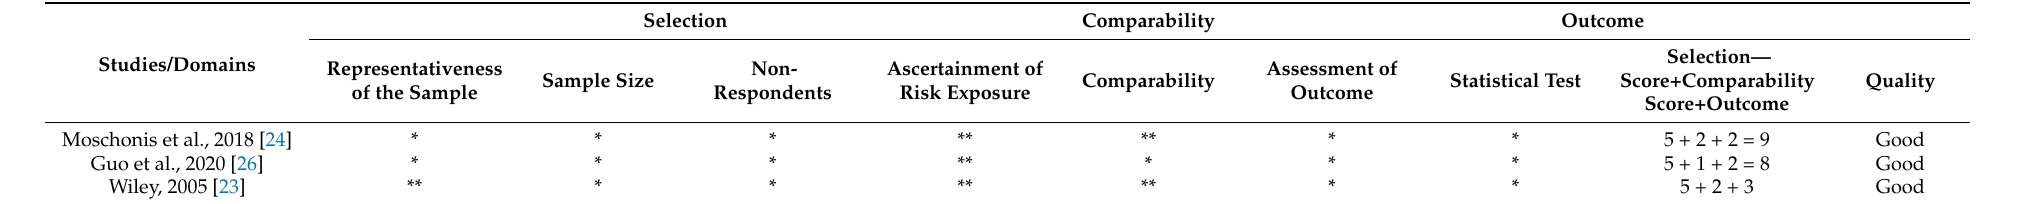
Table 4. Quality assessment of cross-sectional